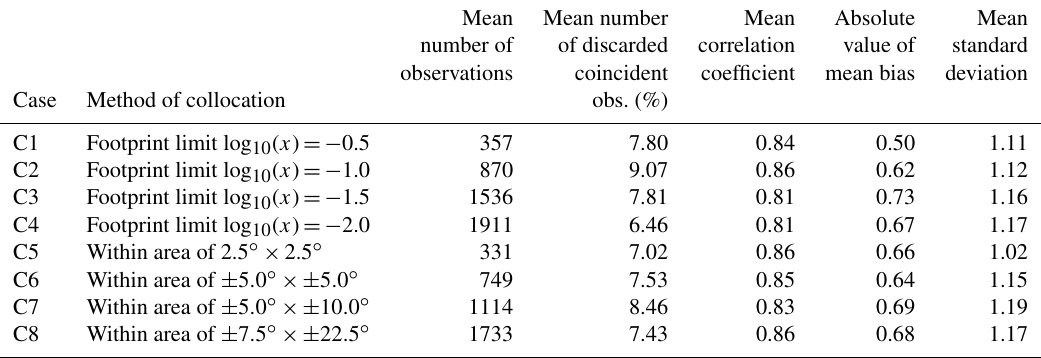
Table 6. Averaged results of different collocation methods implemented for XCO 2 from the GOSAT PPDF product calculated for 16 TCCON